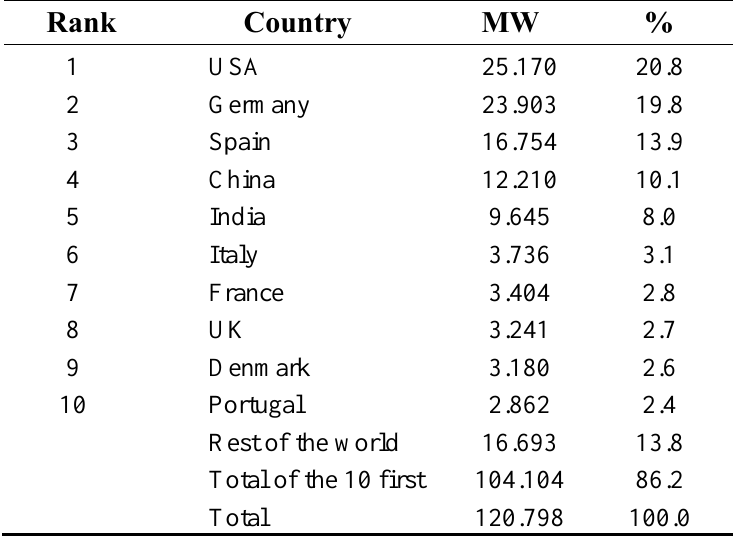
Table 1. World Top 10 in cumulative capacity of installed wind power generation published in [2].